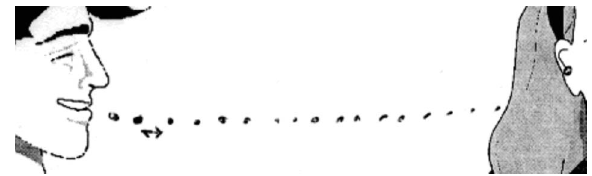
FIG. 14. Student’s drawing over provided template to